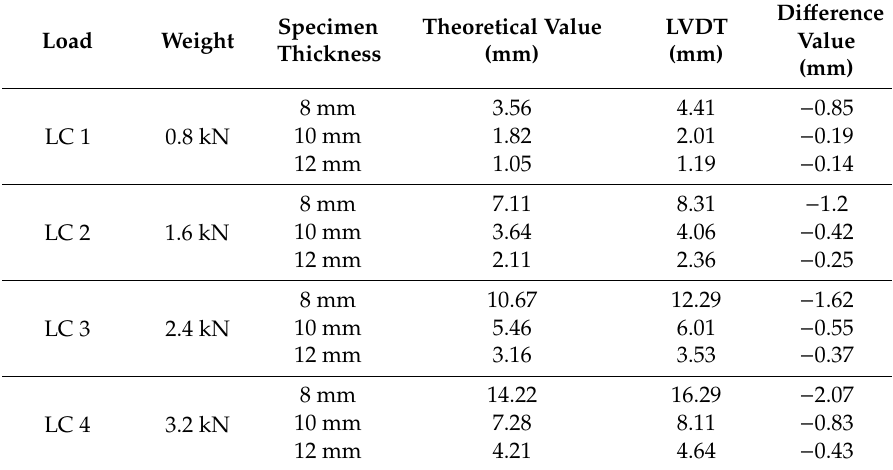
Table 3. Comparison of theoretical value and actual LVDT value.